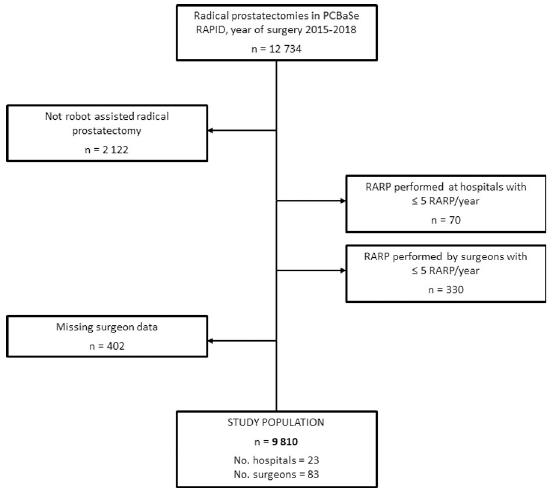
Fig 1. Flow chart of the study population in Prostate Cancer data Base Sweden